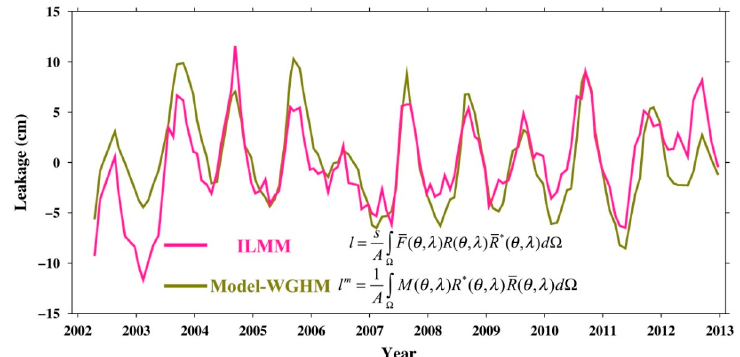
Figure 3. The leakage of the DJKR according to different methods.